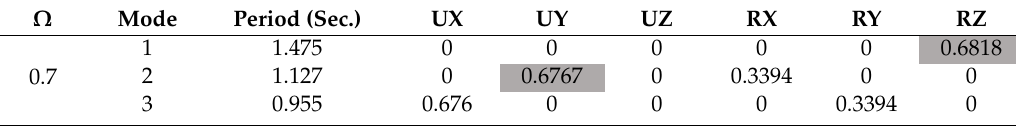
Table 4. Modal Participating Mass Ratio Buildings (with b / r = 3.28, 1 < Ty < 2 s, Ω = 0.7). Ω